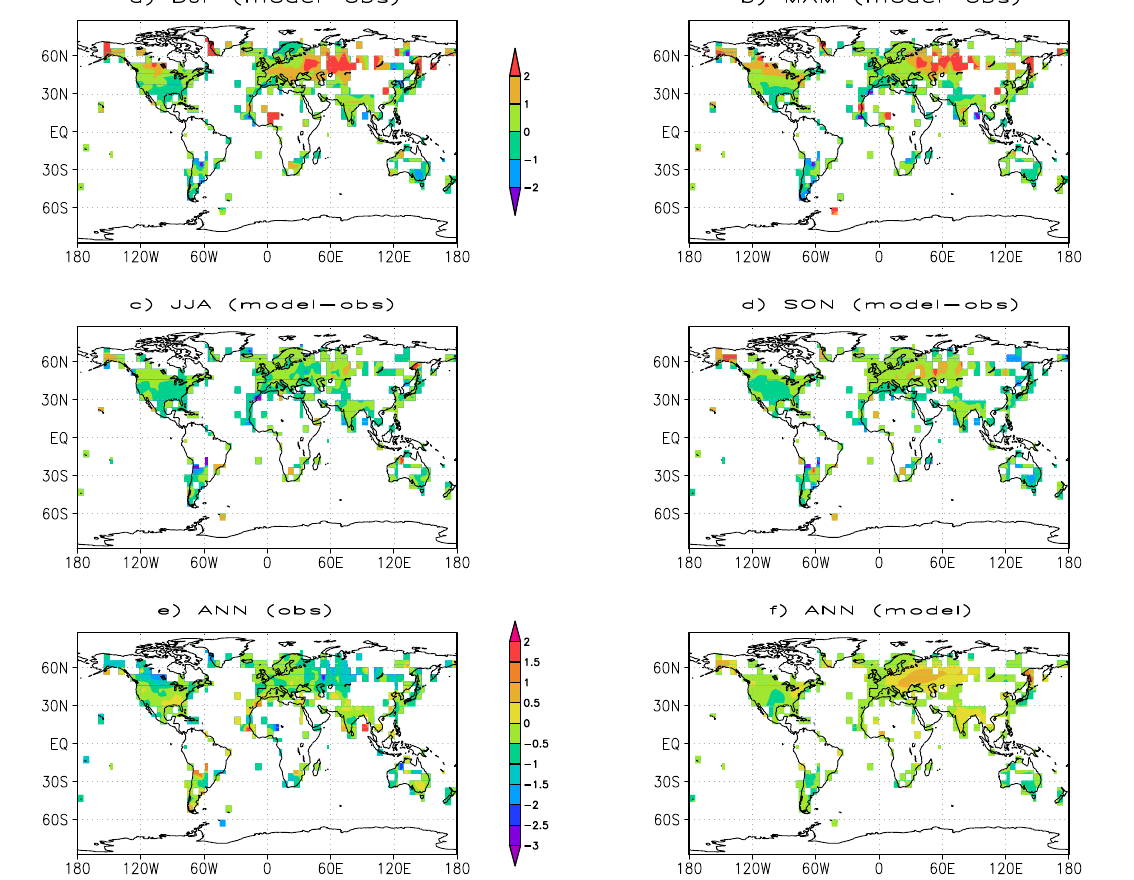
Fig. 3. Maps of seasonal land temperature biases ( ◦ C) averaged over the time period 1890–1900 (a–d) . The maps correspond to the difference between the temperature anomalies from the CTRL ensemble mean and from observations (CRUTEM3), remapped on a T42 grid. The annual temperature maps ( ◦ C) are shown as observed (e) and simulated (f) anomalies, averaged over the time period 1890–1900. Here, the reference period 1960–1990 has been